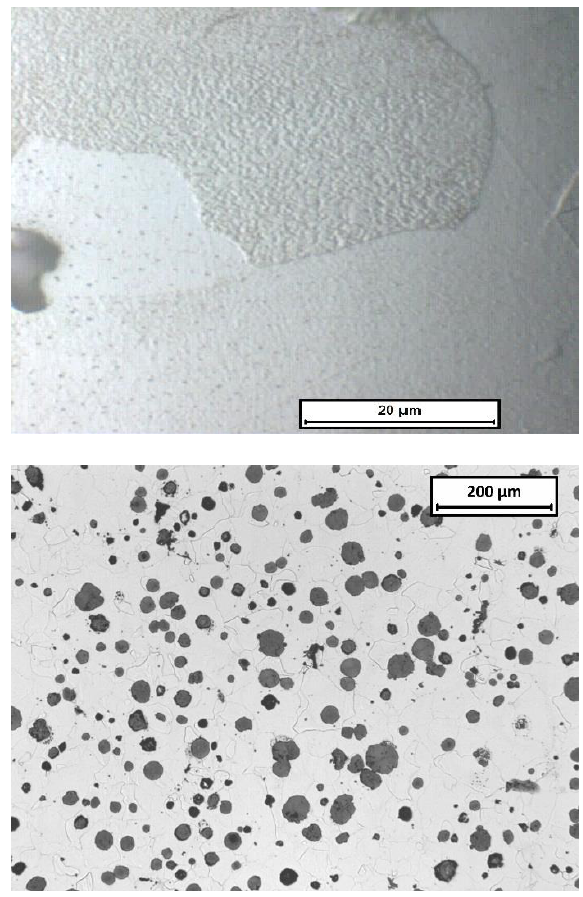
Figure 5. Ferrite (α) and silicumferrite (α 1 ) layering for 3.7% Si HSI after Kallings etching, inspired from the procedure reported in [54], courtesy of Mattias Lundberg RISE ( top ). GJS-500-14 HSI etched in 3% nital (typical microstructure of HSI) courtesy of Vasilios Fourlakidis JU ( bottom ).